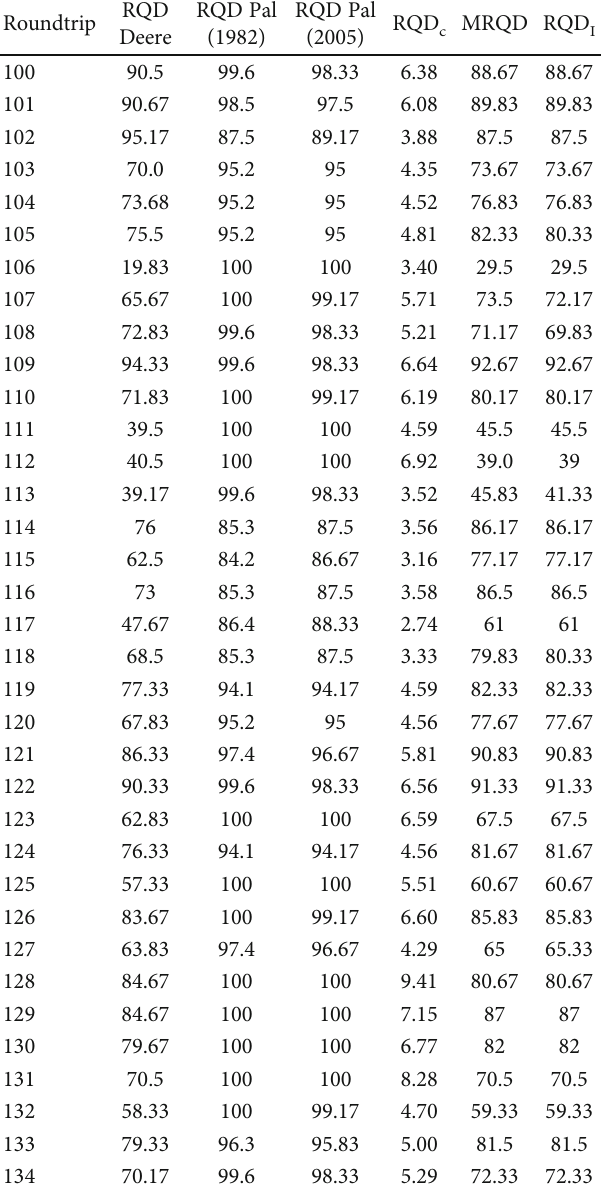
Table 3: Comparison of the four methods for calculating RQD by various researchers for XK-2 drilling cores.